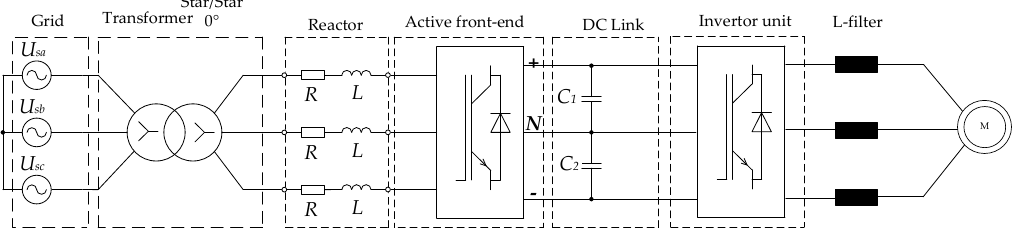
Figure 2. The 6-pulse circuit for connecting the FC-AFE. The electric drives of high-power rolling mills use multi-pulse rectification circuits, usually 12-pulse ones. To accomplish this, two FC-AFEs with a common DC link are connected in parallel. The connections to the frequency converter grid are implemented via matching power